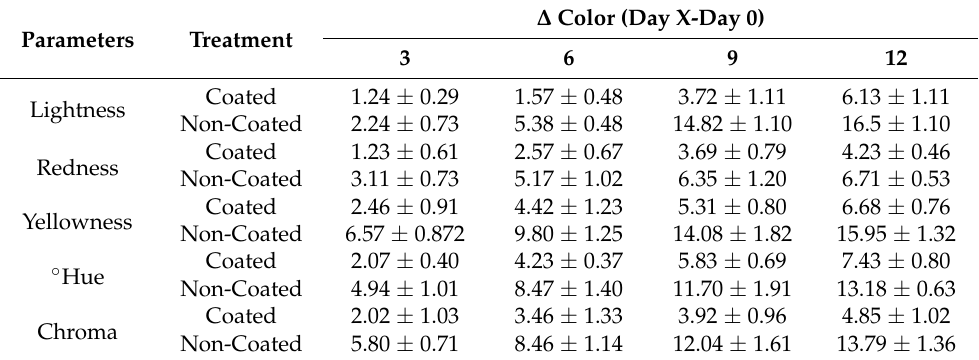
Table 1. Color changes in tomato during storage.